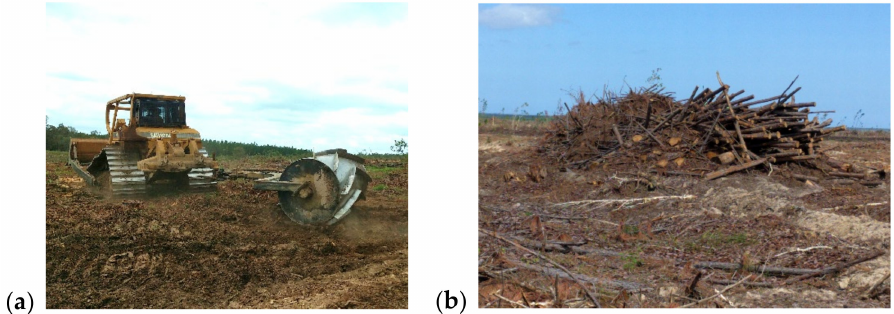
Figure 1. Site preparation operational activities: ( a ) chopper roller and ( b ) roadside pile after excavator manipulation prior to burning. Photos taken by Michael Berry.